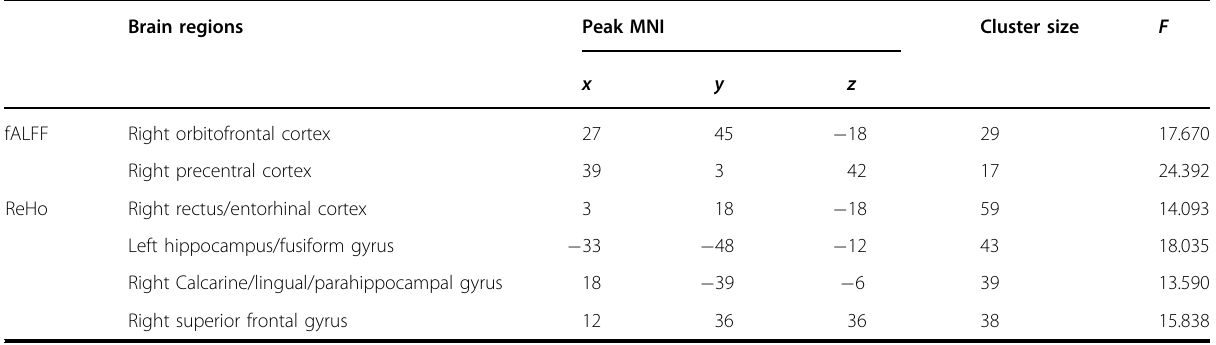
Table 3 Additive effects between LLD and OI dysfunction on brain hypersynchronization. Brain